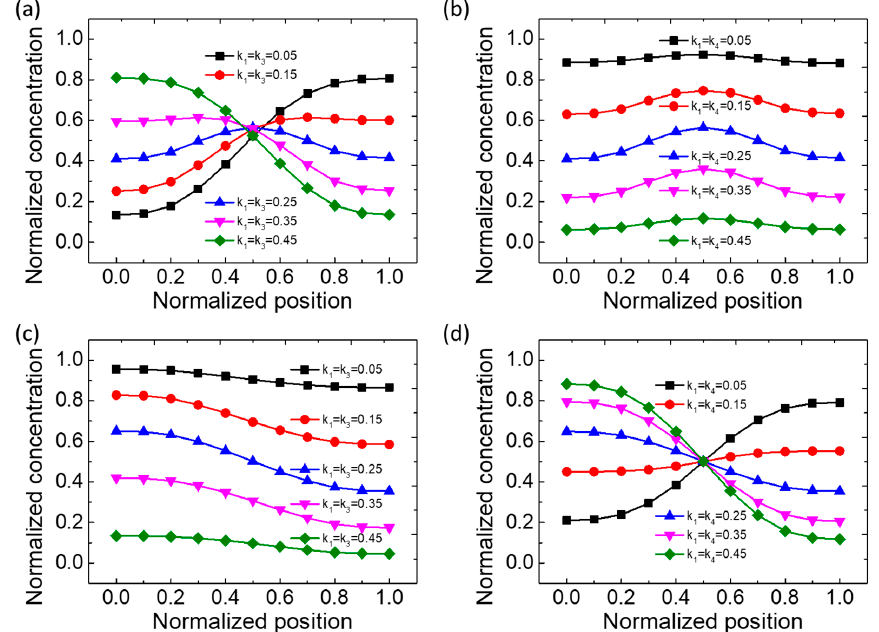
Figure 2. Numerical simulation results of normalized concentration as a function of normalized position at the outlet for the type IV microfluidic device. ( a – d ) show the cases of C = (0, 1, 1, 0) and Q 1 = Q 3 , Q 2 = Q 4 ; C = (0, 1, 1, 0) and Q 1 = Q 4 , Q 2 = Q 3 ; C = (0, 1, 0, 1) and Q 1 = Q 3 , Q 2 = Q 4 ; and C = (0, 1, 0, 1) and Q 1 = Q 4 , Q 2 = Q 3 , respectively.